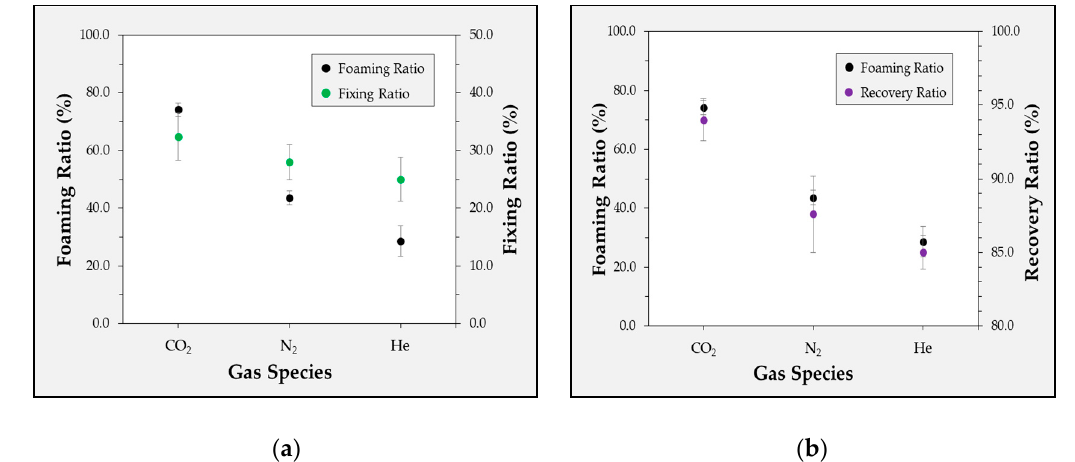
Figure 3. Experimental results for the correlation between the foaming ratio and the fixing ratio ( a ) and recovery ratio ( b ) according to the gas species. Table 6. Foaming properties of thermoplastic polyurethanes (TPU) according to gas species.